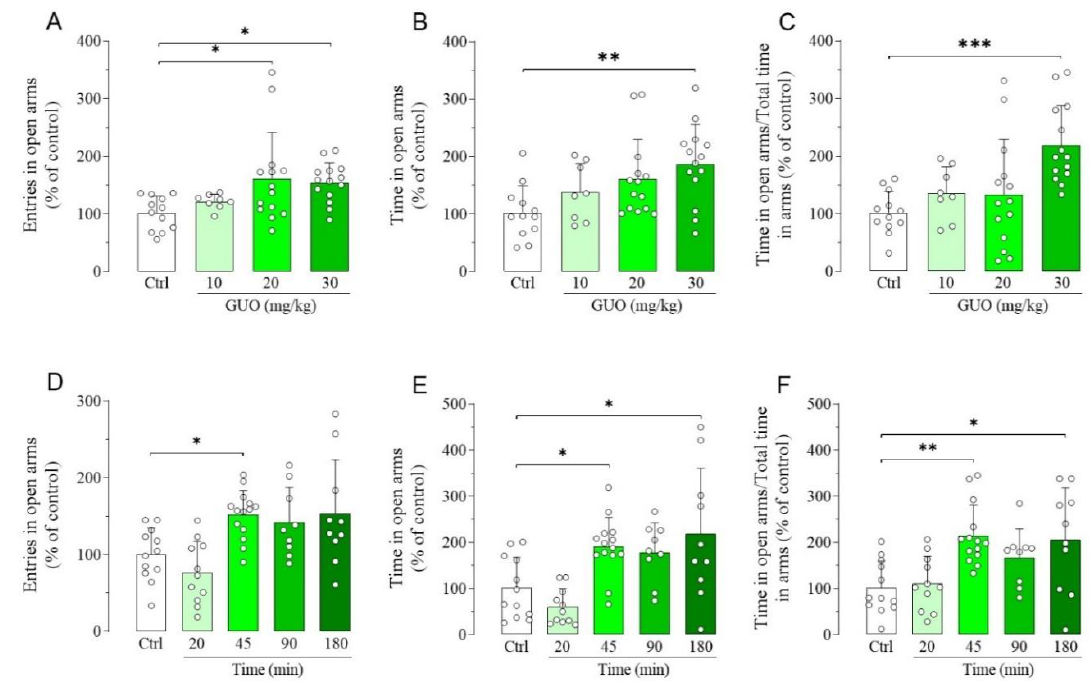
Figure 1. Dose-effect and time-course of guanosine (GUO)-mediated anxiolytic-like effect evaluated by elevated plus maze (EPM) test during a 5 min session. Dose-effect (GUO 45 min): ( A ) number of open arm entries [F (3,44) = 3.929, p < 0.02]; ( B ) time spent in open arms [F (3,44) = 4.441, p < 0.01]; ( C ) ratio time in open arms and total time in arms [F (3,44) = 6.939, p < 0.001]. ( D – F ) Time-course (30 mg/kg GUO): ( D ) number of open arm entries [F (4,51) = 6.710, p < 0.0005]; ( E ) time spent in open arms [F (4,51) = 7.672, p < 0.0001]; ( F ) ratio time in open arms and total time in arms [F (4,51) = 6.148, p < 0.0005]. Ctrl: Control group. Each bar represents the mean value ± SD. Tukey test: * p < 0.05, ** p < 0.01, *** p < 0.001. Ctrl raw mean values: ( A ) 6.75; ( B ) 60.05 s; ( C ) 0.27; ( D ) 8.58; ( E ) 95.84 s; ( F ) 0.45.